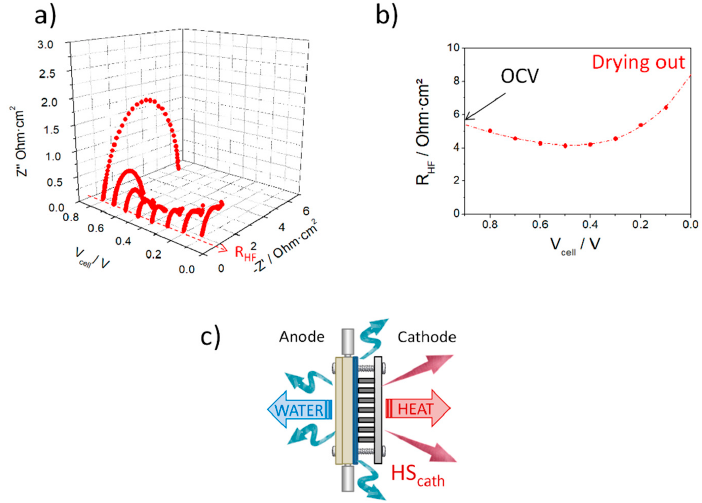
Figure 10. ( a ) Electrochemical impedance spectra registered at different voltages for a commercial MEA assembled in the ABPEMFC design with a heat sink at the cathode; ( b ) High-frequency resistance of the Nyquist plots series as a function of the cell voltage; ( c ) Scheme of the cell configuration showing the flows of heat and water.